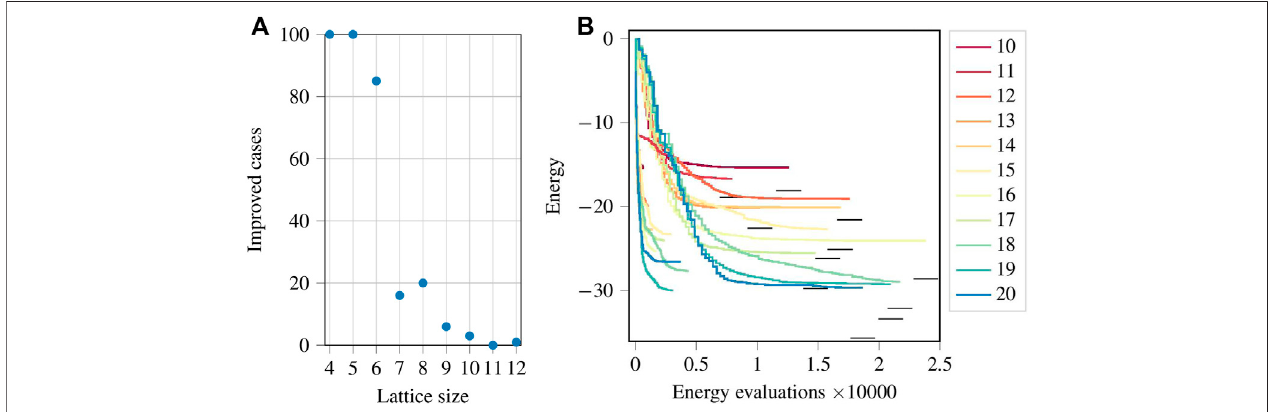
FIGURE 5 | (Colour online) (A) : The number of cases where the fi nal energy obtained using random initial parameters was either equal to or lower than the energy obtained by setting zeros as initial parameters. (B) : Optimization progress for the ansatz given by Eq. 9 for p = 1 (group of shorter lines on the left) and p = 5 (group of longer lines on the right). The legend shows the lattice size. The short horizontal black lines represent the ground state